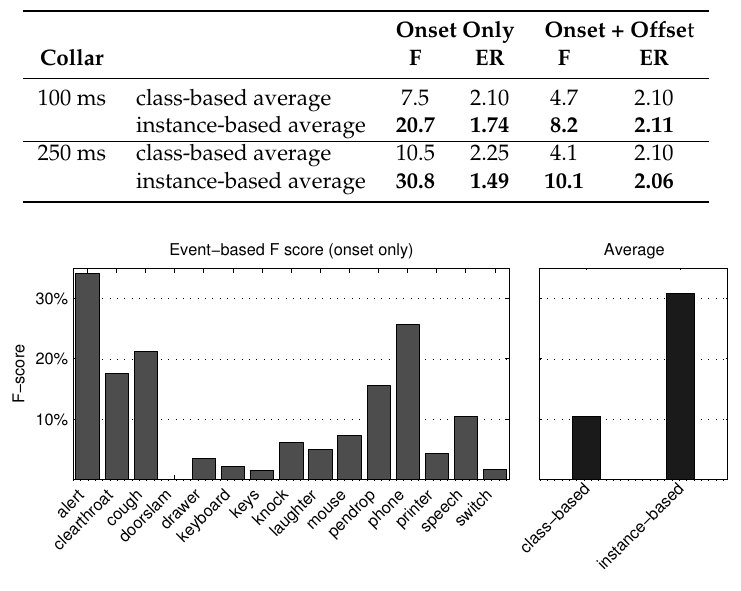
Figure 7. Event-based F-score for the case study system, 250 ms collar, onset